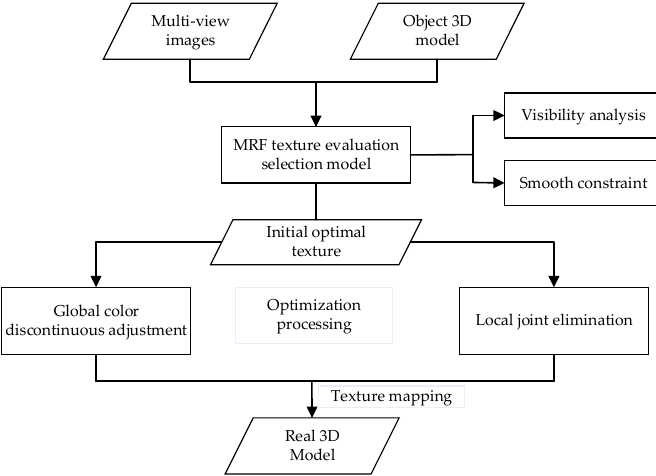
Figure 2. Texture-mapping based on Markov random field (MRF) model.